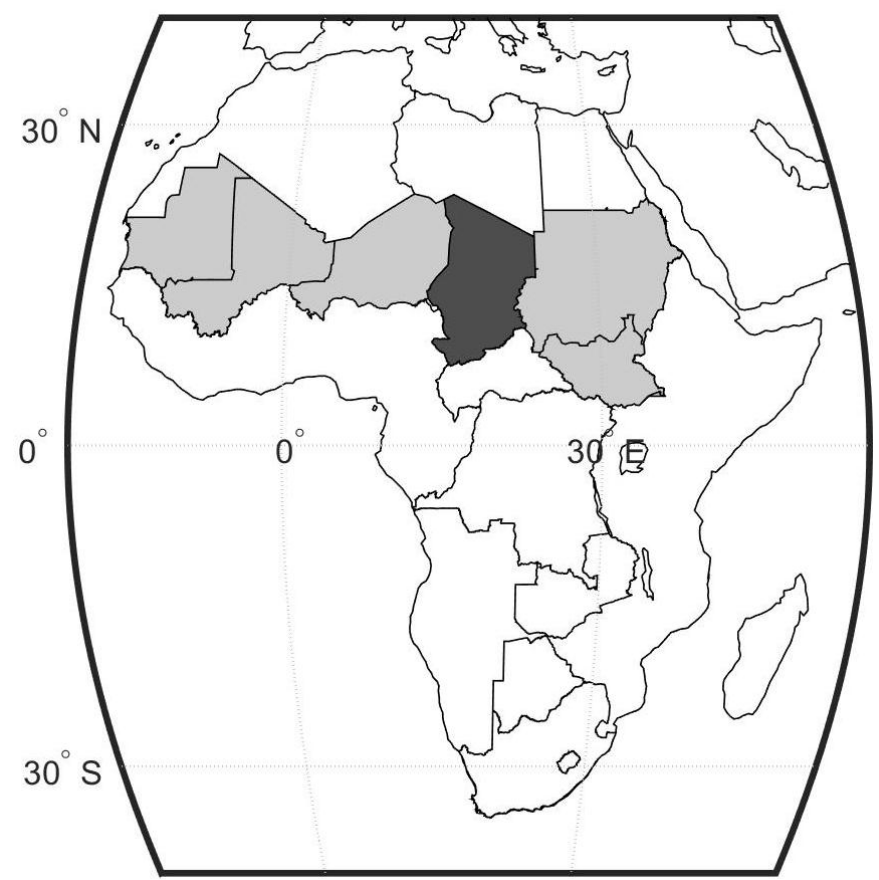
Figure 1. Map of Africa showing the nations modelled in the north-south (white) and west-east (light grey) transects. Note that Chad (dark grey) is in both transects. The new nation of South Sudan is outlined within the most eastern nation of Sudan.